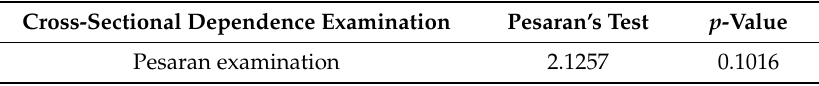
Table 3. Cross-sectional dependence examination